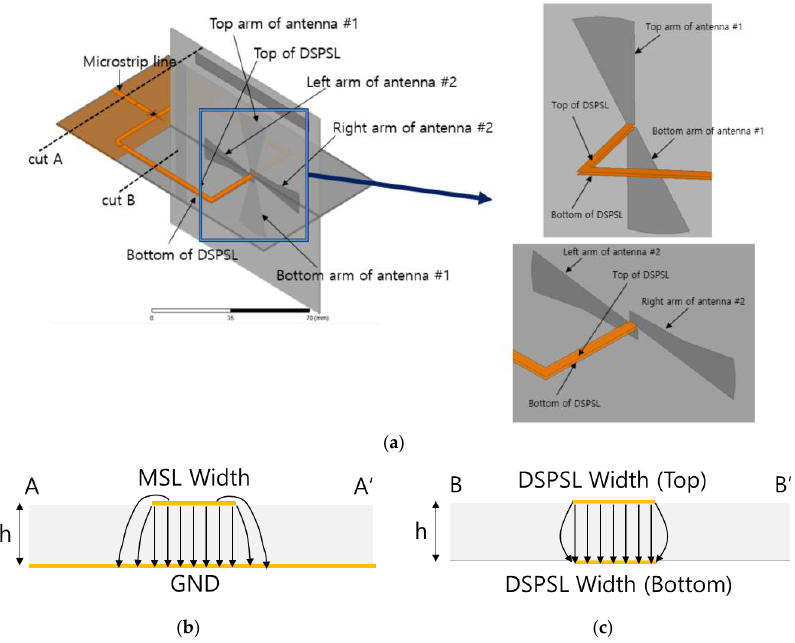
Figure 5. ( a ) 3D-view of antenna with switching network; ( b ) E-field distribution of cut A plane (microstrip line); ( c ) E-field distribution of cut B plane (double-sided parallel-strip transmission line).